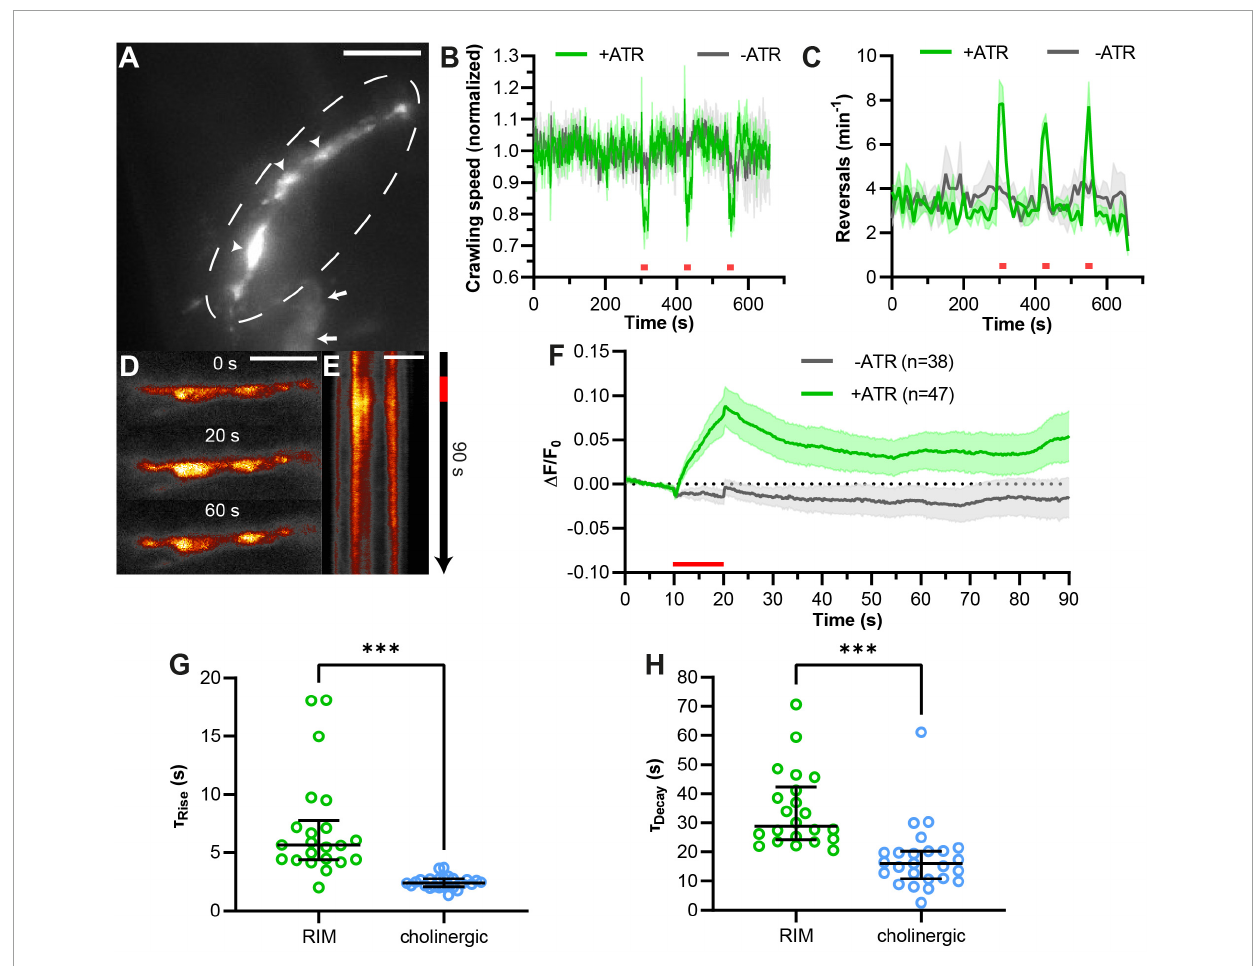
FIGURE5 pOpsicle assay in the RIM interneuron pair. (A) Representative Z -projected image of C. elegans expressing SNG-1::pHluorin in RIM neurons using the promotor of tdc-1 . 40 × magnification. Arrows represent cell bodies of RIM neurons. Circle represents RIM axon in the nerve ring. Arrowheads represent fluorescent puncta, representing en passant synaptic terminals. 40 × magnification. Scale bar, 5 µ m. (B) Mean crawling speed ( ± SEM) of animals expressing ChrimsonSA and pHluorin in RIM neurons normalized to the average before the first light pulse. Three 20 s light pulses (623 nm, 400 µ W/mm 2 ) were applied at 300, 420, and 540 s as indicated by red bars. (C) Mean ( ± SEM) number of reversals per minute per animal. Light stimulation as in panel (B) . In panels (B,C) , N = 3 populations of animals were tested. (D) Representative images acquired at different time points during the pOpsicle assay, pHluorin fluorescence in RIM neurons, animal treated with ATR. A 10 s continuous light pulse (590 nm, 40 µ W/mm 2 ) was applied after 10 s. The ImageJ Smart Look-Up-Table was used. 100 × magnification. Scale bar, 5 µ m. (E) Kymograph representing the change in fluorescence in RIM neurons as shown in panel (D) over a time course of 90 s. The red bar indicates the period of light stimulus. Scale bar, 5 µ m. (F) Mean ( ± SEM) pHluorin fluorescence in RIM neurons of animals with and without ATR. A 10 s continuous light pulse (590 nm, 40 µ W/mm 2 ) was applied after 10 s. Number of animals ( n ), accumulated from N = 5 (+ATR) or N = 4 (–ATR) biological replicates. (G) Comparison of fluorescence rise constants of single animals expressing pHluorin and ChrimsonSA in RIM neurons or in cholinergic neurons, using a one-phase exponential fit during stimulation (10–20 s). Median with interquartile range. Mann–Whitney test ( ∗∗∗ p < 0.001). (H) Comparison of fluorescence decay constants of single animals as in panel (G) , using a one-phase exponential fit after stimulation (20–90 s). Median with interquartile range. Mann–Whitney test ( ∗∗∗ p < 0.001). (G,H) Only animals showing a strong response during stimulation and a decay of fluorescence after stimulation were taken into consideration (RIM: 22 of 47 animals, cholinergic neurons: 25 of 27 animals as depicted in Figure 2